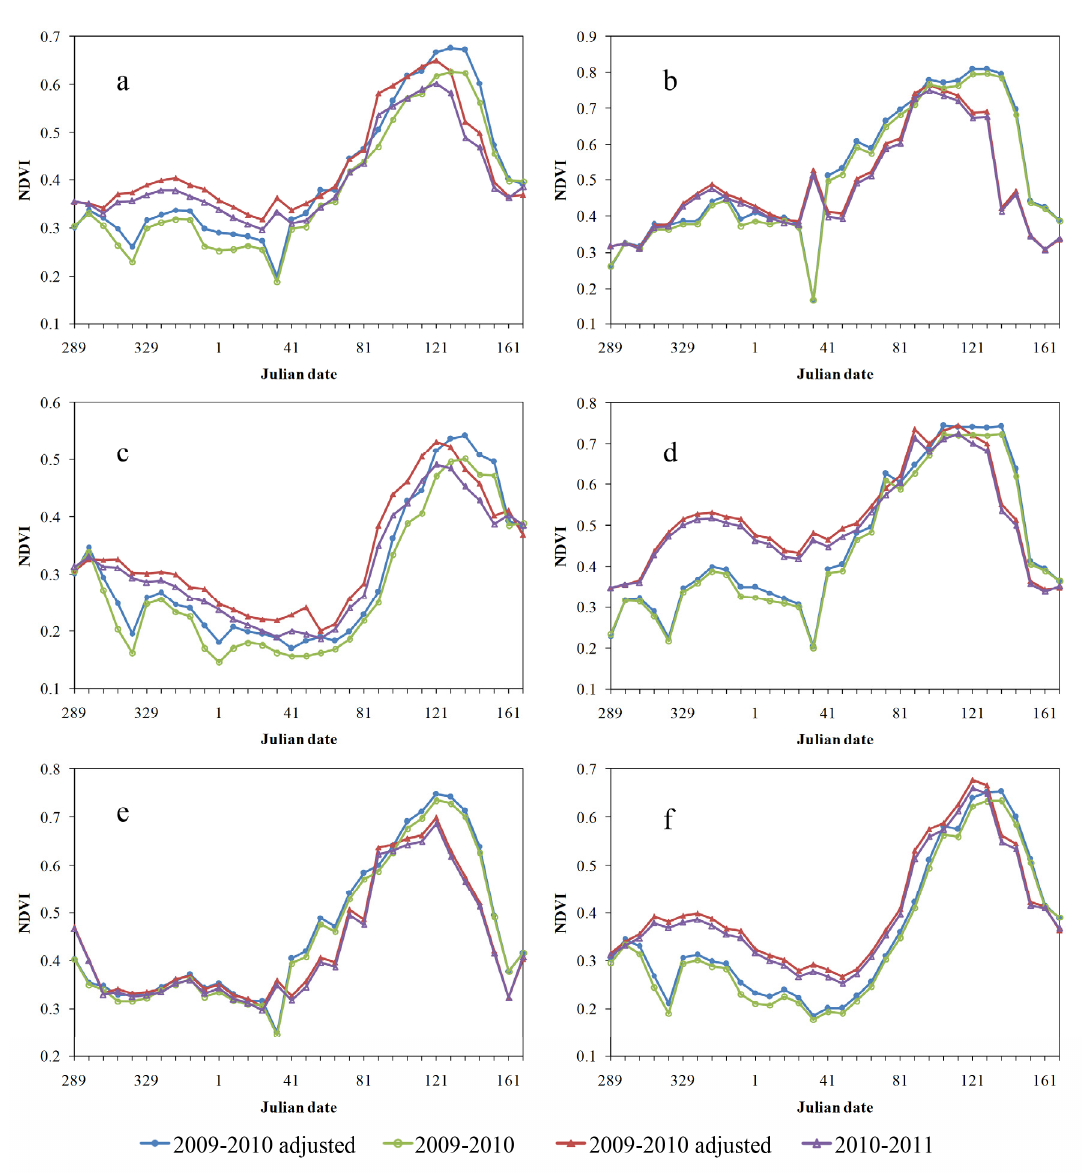
Figure 10. Crop growth profiles for North China Plain ( a ) and five provinces: Anhui ( b ), Hebei ( c ), Henan ( d ), Jiangsu ( e ) and Shandong ( f